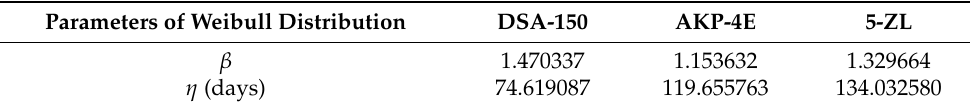
Table 3. Parameters of Weibull distribution for the analyzed types of pantograph.